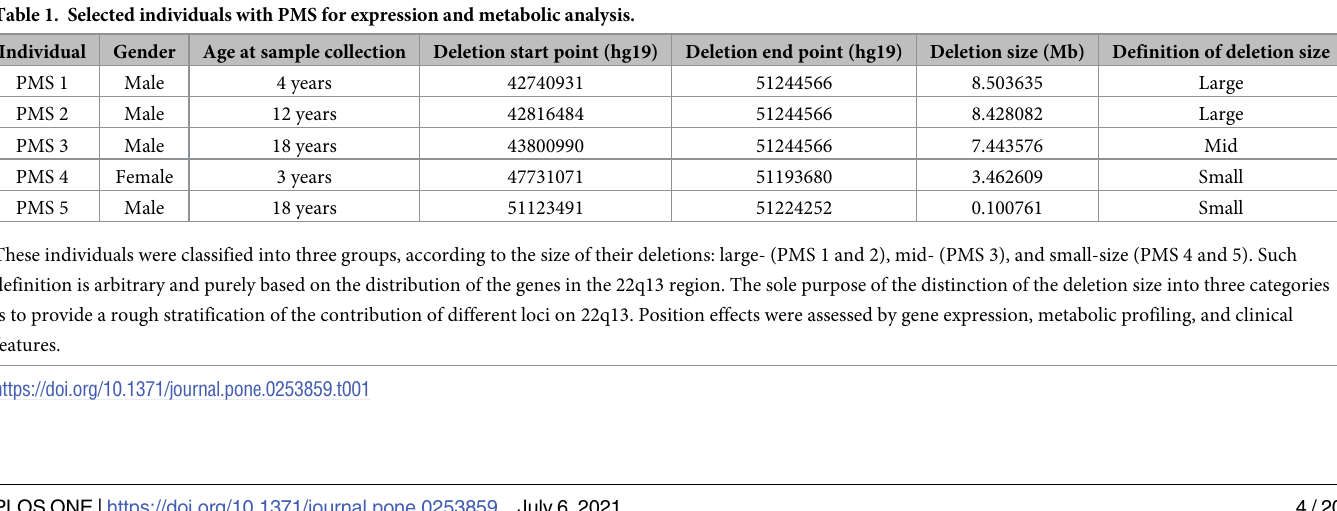
(= < 10%), and phenotypic overlap above the 75 th percentile [30]. From this analysis, 12 candi- date genes were identified. These 12 candidate genes were then selected for expression analysis as one method of validation.